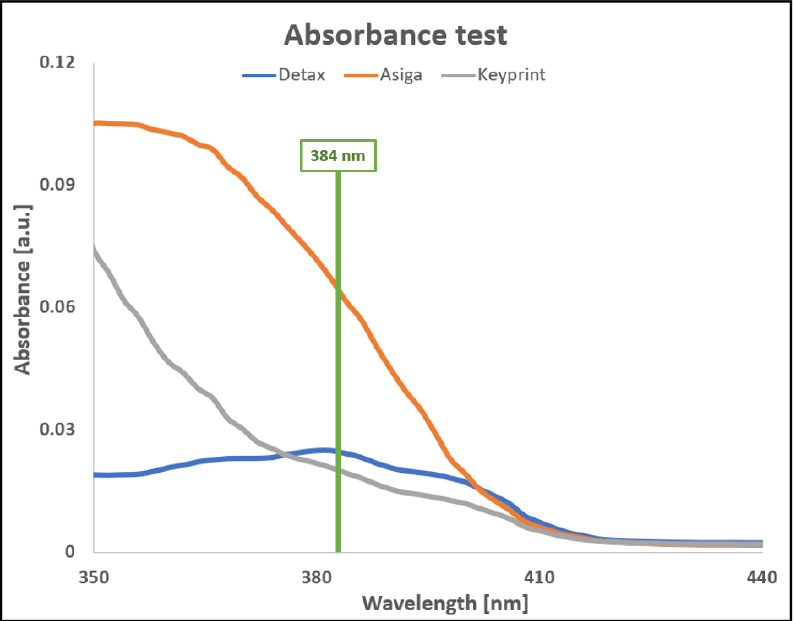
Figure 4. Graph presenting the absorbance for three commercial resins and its dependency with respect to the light wavelength, from 350 nm to 440 nm. respect to the light wavelength, from 350 nm to 440